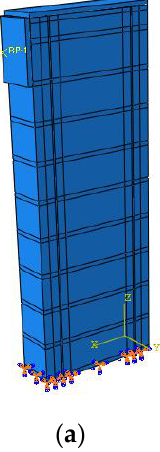
Figure 12. The Abaqus Finite Element Model. ( a ) Overall Model. ( b ) H-shape Steel. ( c ) Reinforcement Skeleton. ( d ) Contact Condition.